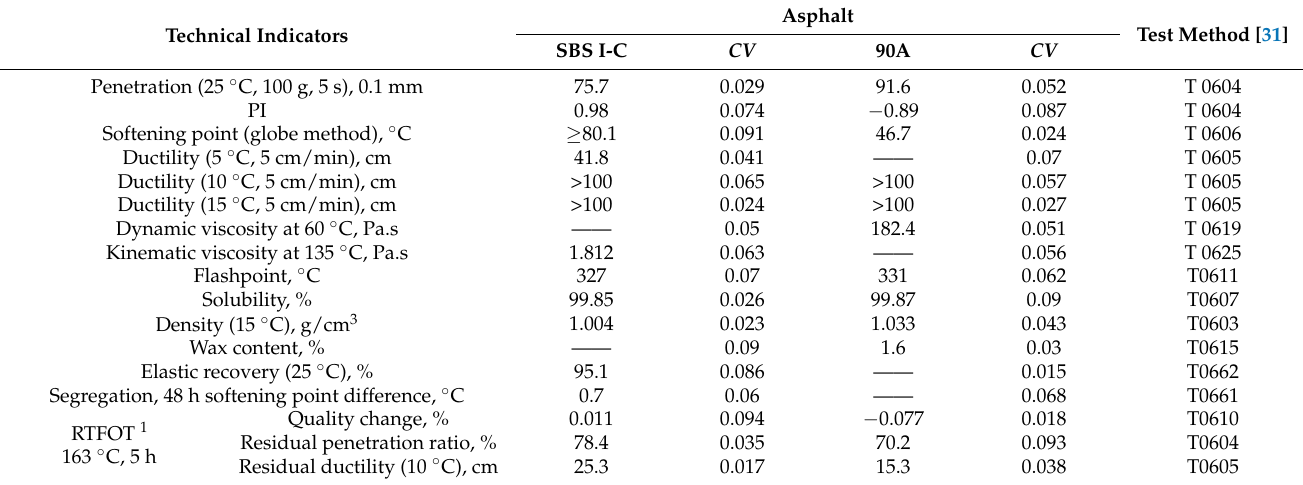
Table 3. Technical indicators of